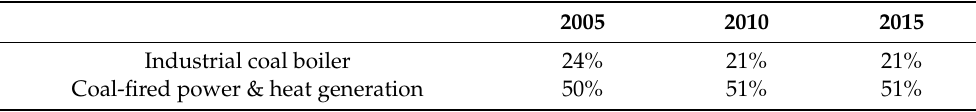
Table A6. The proportion of coal used for industrial coal boilers and coal-fired power and heat